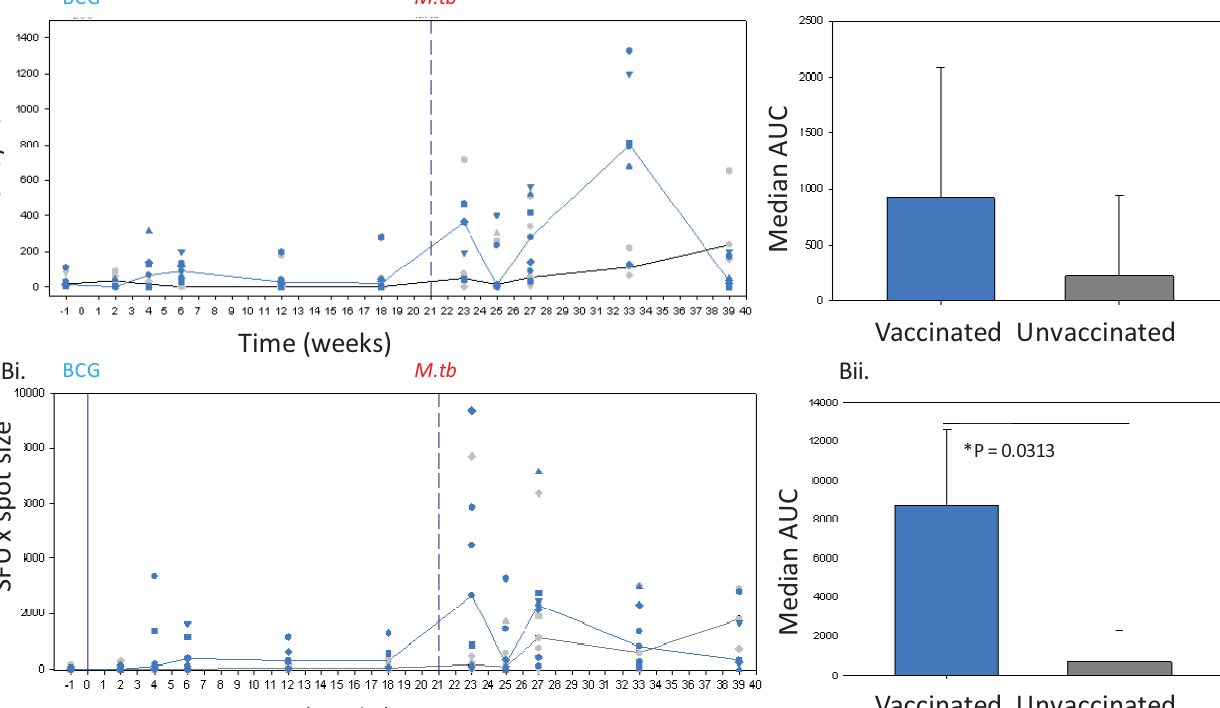
Figure 2. The IFN(cid:2) response to BCG vaccination (solid line) and challenge with M. tb (dashed line) in Chinese cynomolgus macaques measured by ELISPOT. Panel A shows the frequency of PPD-specific IFN-(cid:2) secreting cells in PBMC measured as SFU/10 6 in individual BCG vaccinated n = 6 (blue symbols) and unvaccinated n = 6 (grey symbols) macaques and the median response in each group (BCG vaccinated group, blue line, unvaccinated group, black line) ( Ai ) and the median area under the SFU curves (AUC) calculated for BCG vaccinated (blue bar) and unvaccinated (grey bar) study groups during the vaccination phase and compared using a Mann Whitney test ( Aii ). Panel B shows the IFN(cid:2) response profiles determined using spot size x quantity from individual BCG vaccinated (blue symbols) and unvaccinated (grey symbols) macaques and the median response in each group (BCG vaccinated group, blue line, unvaccinated group, grey line) ( Bi ), and the median area under the spot size x quantity curves (AUC) calculated for BCG vaccinated (blue bars) and unvaccinated (grey bars) study groups during the vaccination phase and compared using a Mann Whitney test ( Bii ).